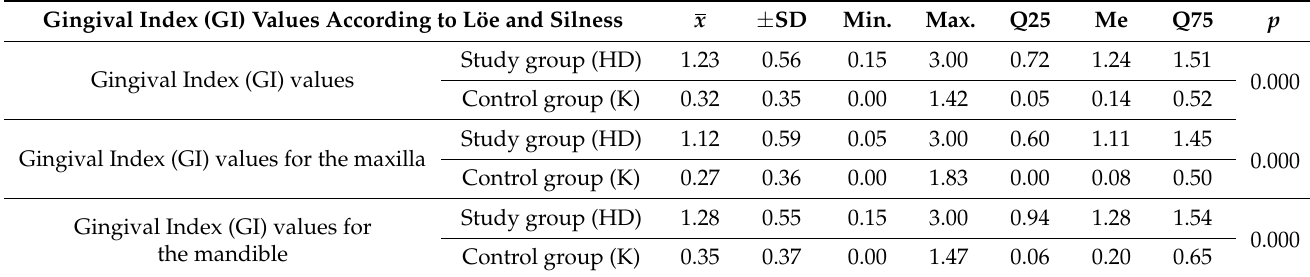
Table 8. Mean Gingival Index (GI) values according to Löe and Silness in the study groups.